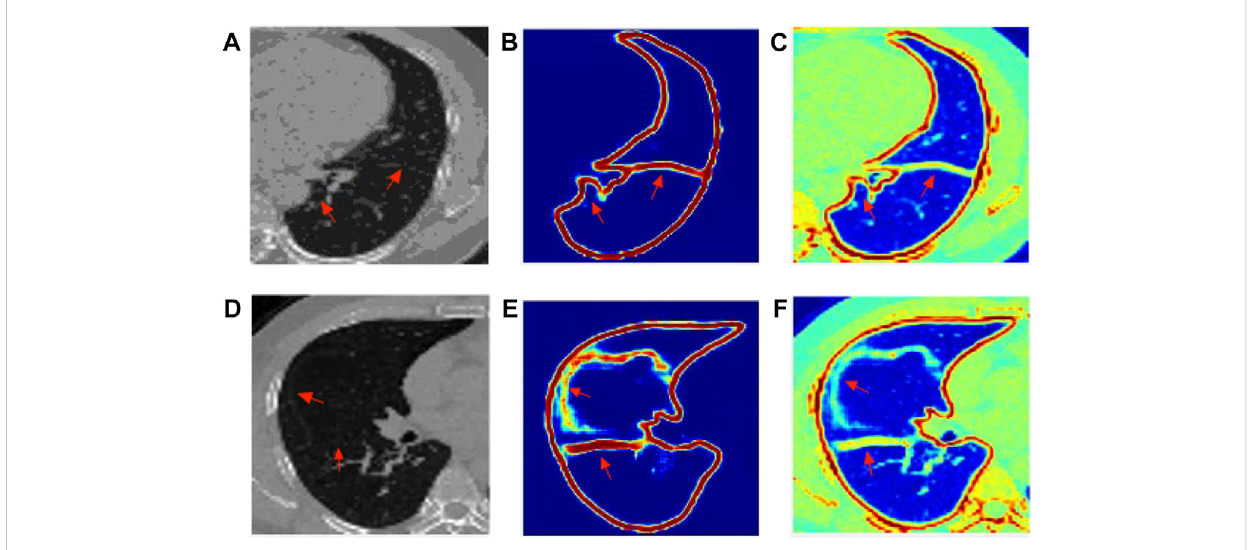
FIGURE 4 The visualization results of edge response map generated by EG-Net: (A) left lung origin data; (B) Boundary and fi ssure response generation map of theleftlung; (C) Theresultingresponsemapismappedtotheoriginalimage; (D) rightlungorigindata; (E) Boundaryand fi ssureresponsegenerationmap of the right lung; (F) The resulting response map is mapped to the original image.